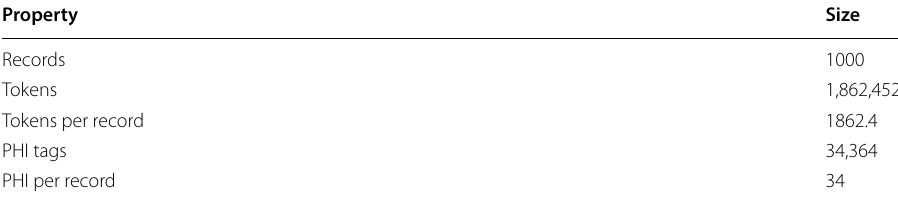
Table 4 2016 CEGS N‑GRID Dataset [49]